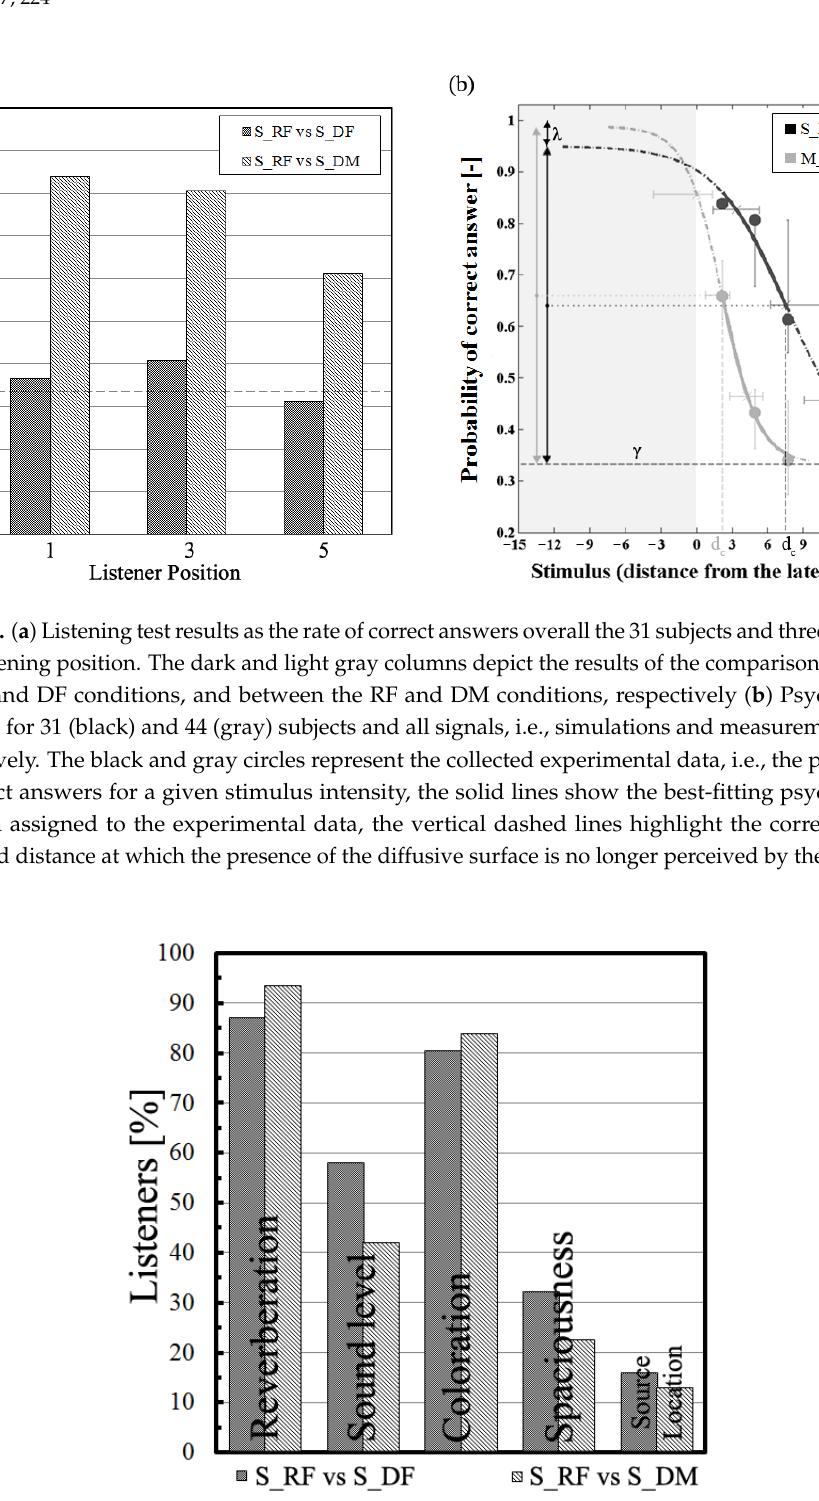
Figure 10. Listeners’ subjective evaluations on the perceived differences between the simulated reflective (RF) and diffusive conditions (DF and DM). The y -axis depicts the percentage of listeners that reported the attributes given in the x -axis.